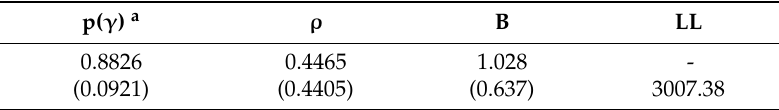
Table 1. Population mean and standard deviation of individual parameter estimates and the aggregated Log-likelihood(LL), Equation